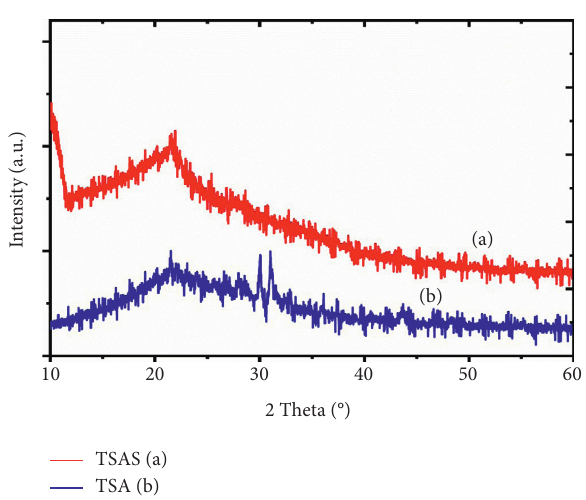
Figure 2: XRD spectra of (a) biosilica nanoparticle from teff straw and (b) teff straw ash.